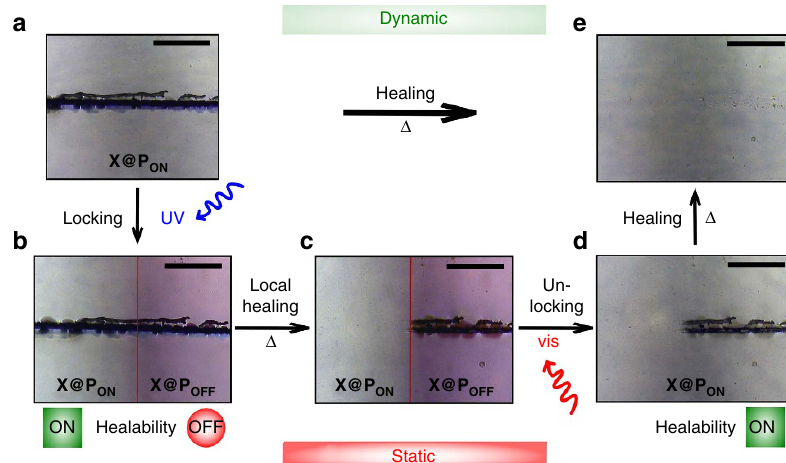
Figure 2 | Visualization of macroscopic scratch healing with and without light control. Micrographs of a scratched thin film of X@P ON , which is healed on heating to 124 (cid:2) C for 5min in vacuum ( a , e ) (dynamic system). After illuminating the right side of the scratched film with a 365nm LED for 30min under an argon atmosphere ( a , b ), the scratch is fixated on heating to 124 (cid:2) C for 5min in vacuum ( X@P OFF , b , c ) whereas the healing ability on the left side ( X@P ON ) remains switched ‘on’. The healing ability of X@P OFF is regenerated after illumination with a 460nm LED for 105min under an argon atmosphere ( c , d ) and after heating to 124 (cid:2) C for 5min in vacuum ( d , e ). Scale bar,